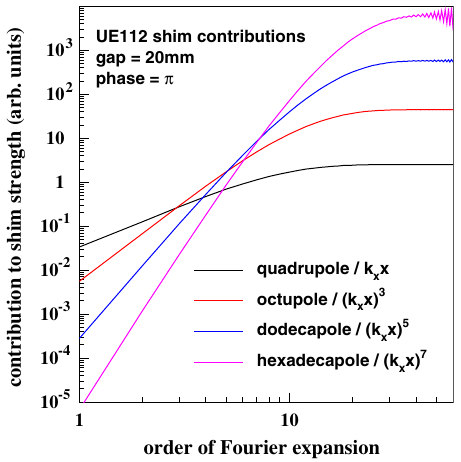
FIG. 12. Contributions from different Fourier components to the lowest order multipoles of the L shims. With increasing multipole order the contributions of low order Fourier compo- nents decrease. This is the reason for the similar gap scaling of L shims and dynamic multipoles (see